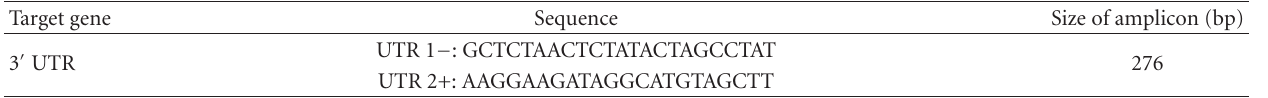
Table 1: RT-PCR primer